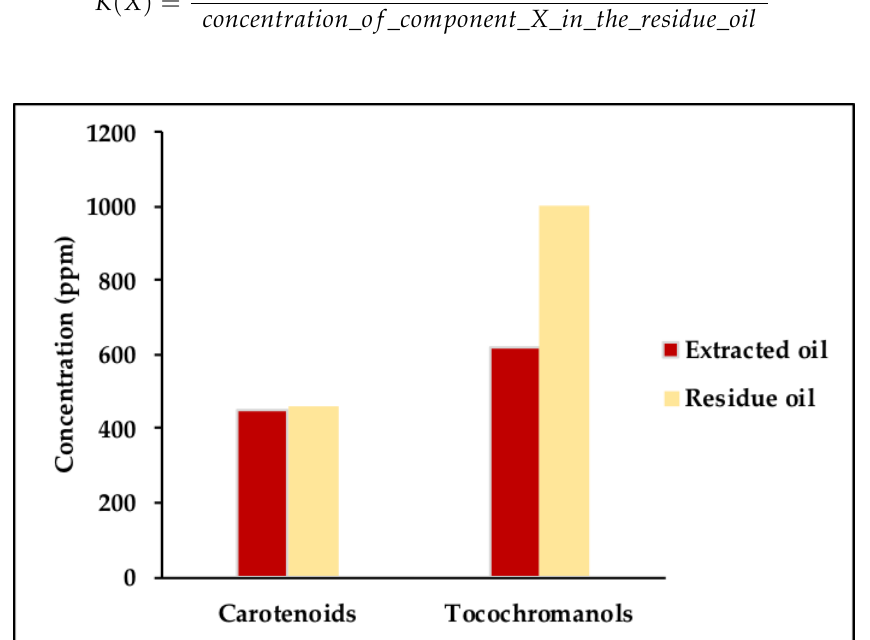
Figure 5. Carotenoids as extracted with SCCO 2 at 45 °C and 14 kg h −1 kg −1 .